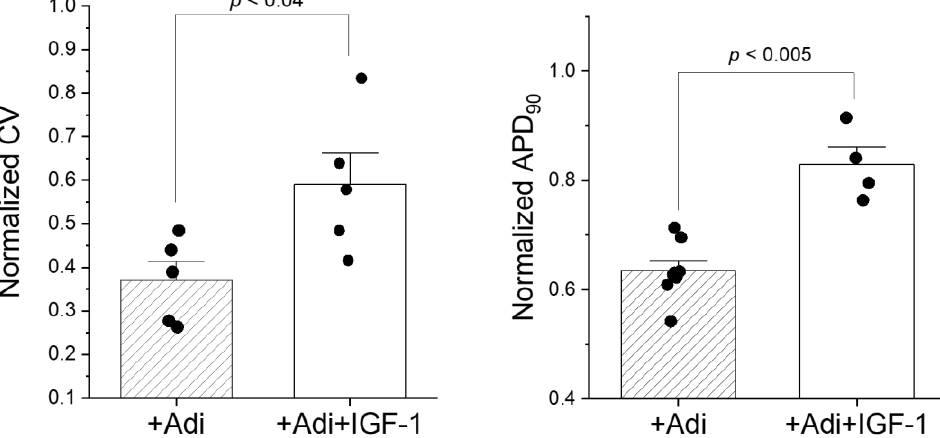
Figure 9. Summary data for conduction velocity (CV, left, n = 5, n = 5) and APD 90 (right, n = 8, n = 4) when cardiac myocytes were co-cultured with pro-adipogenic factors that did (solid white bars) and did not (hatched bars) include IGF-1 supplementation. All CV and APD 90 values are normalized to values measured in cardiac myocytes